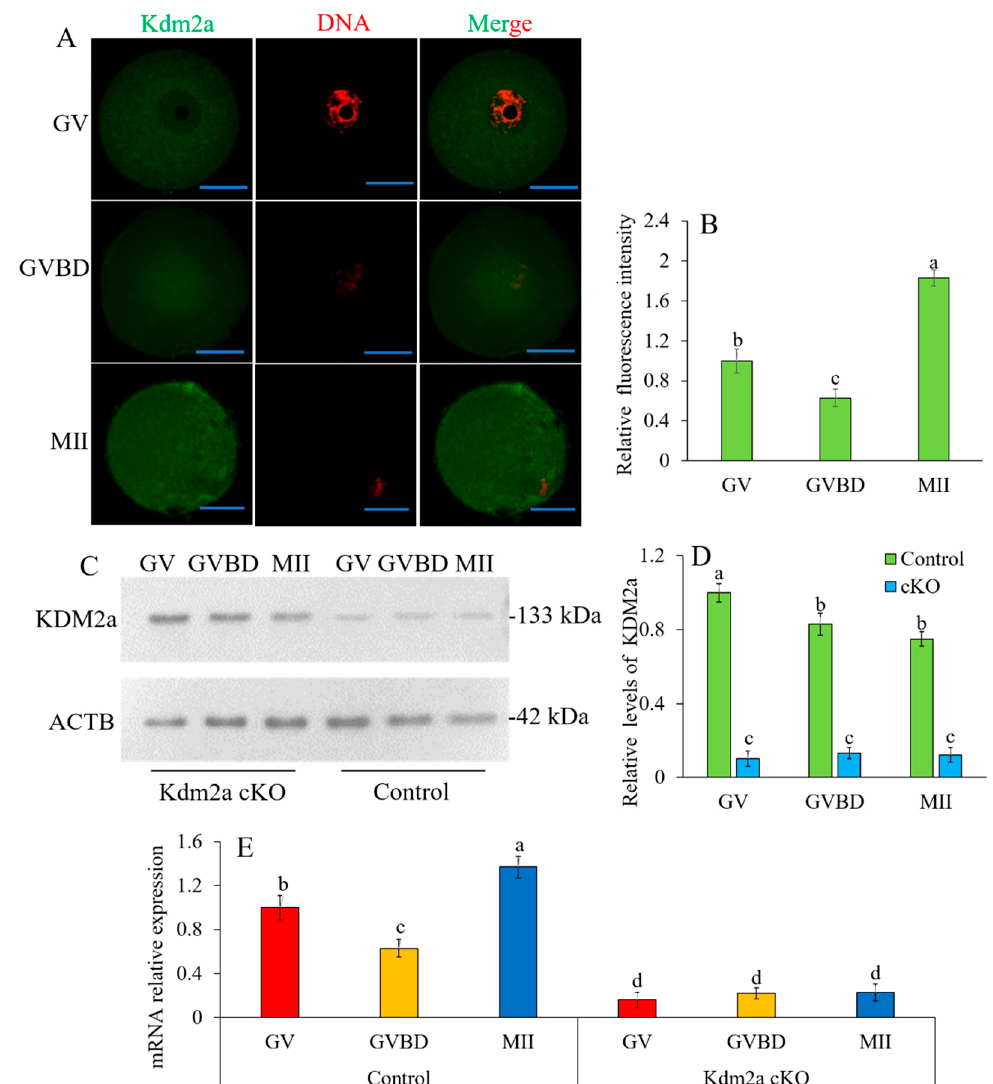
Figure 3. Subcellular localization and expression of Kdm2a during oocyte meiotic maturation. ( A , B ) Immunofluorescence analysis was utilized to track the spatial profile of KDM2a in GV, GVBD, and MII stages oocytes. Oocyte were labeled with anti-KDM2a followed by appropriate Alexa Fluor- conjugated secondary antibodies (green) and were counterstained with the nuclear stain PI (red). ( C , D ) Protein levels of KDM2a in oocytes at GV, GVBD, and MII stages were examined by western blot. ( E ) RT-qPCR analysis of Kdm2a mRNA relative expression levels in oocytes. The different su- perscript letter showed significant difference ( p < 0.05). Scale bars, 50 μ m.